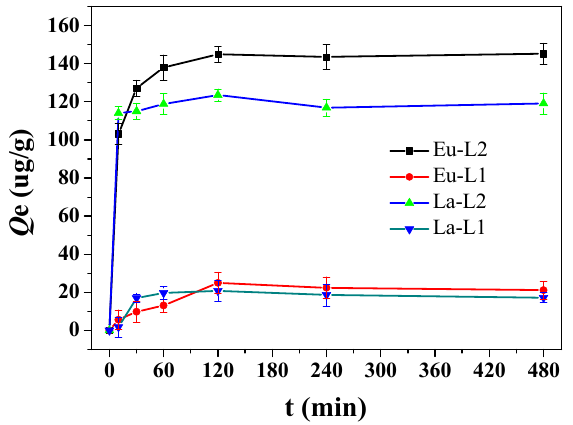
Figure 1. The adsorption capacity of La(III) and Eu(III) by using L1 or L2.